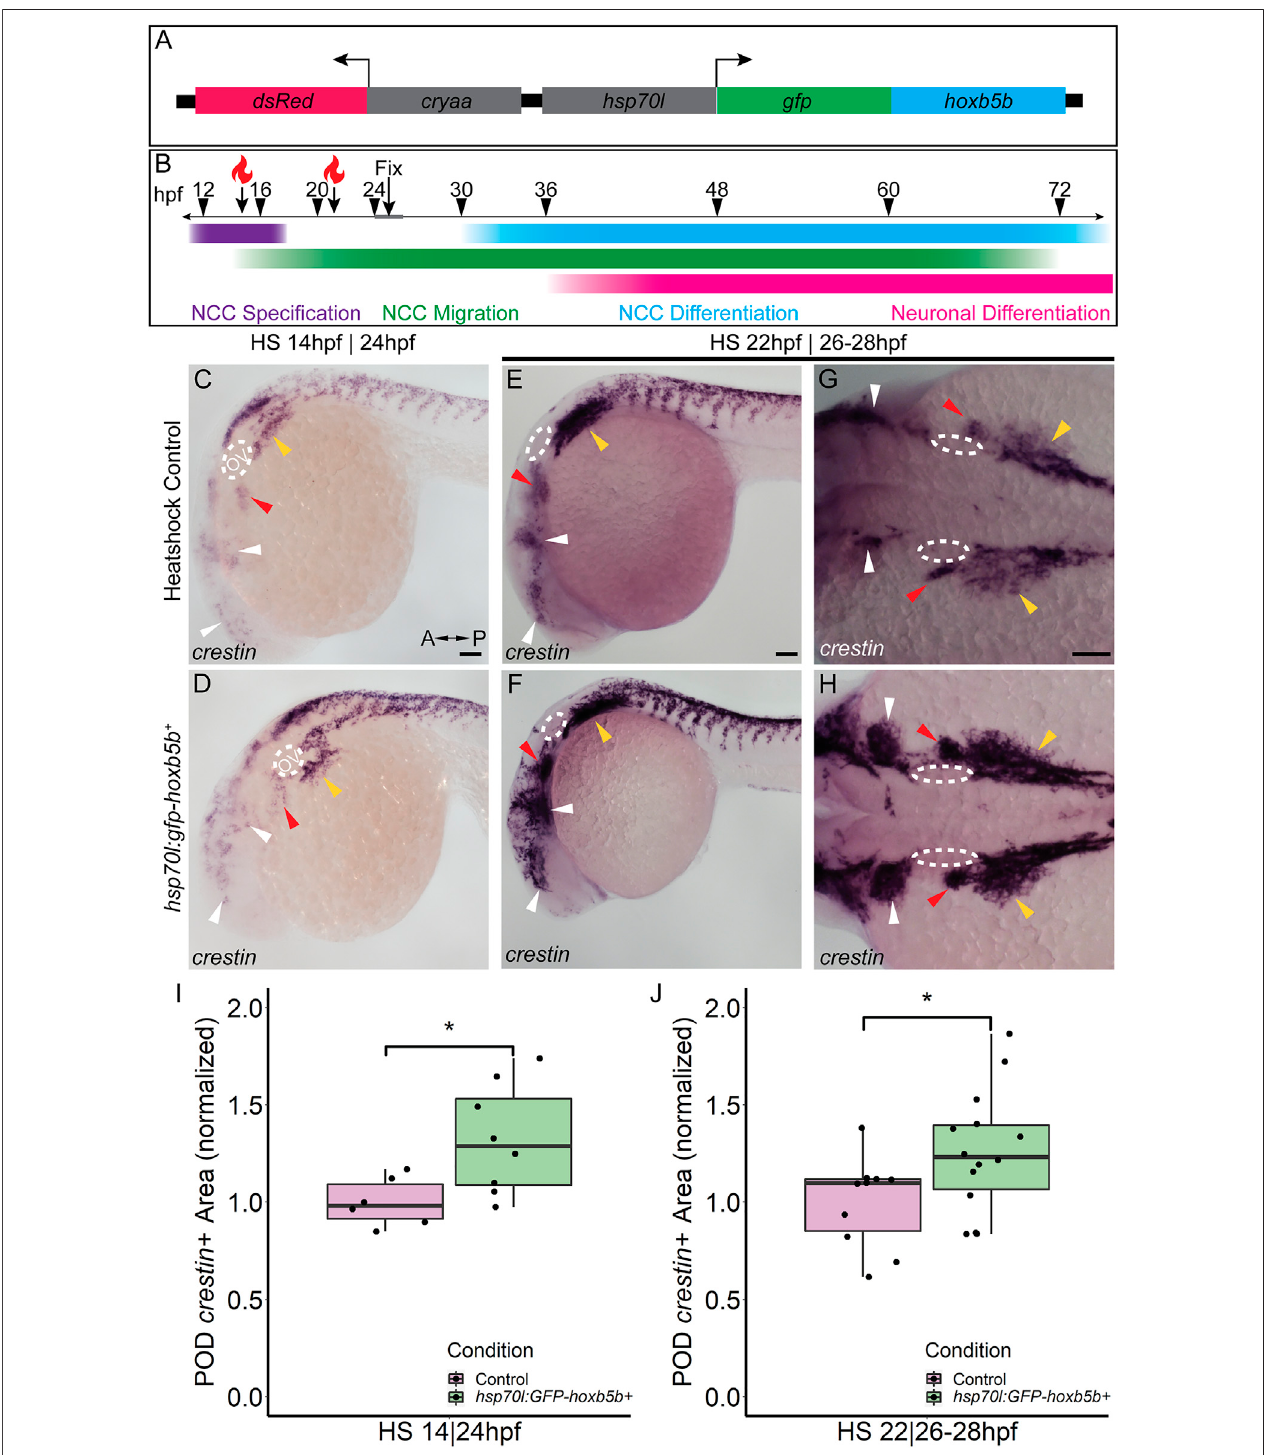
FIGURE 4 | Temporally controlled overexpression of Hoxb5b during the fi rst day in development is suf fi cient to expand the neural crest pool. (A) Schematized modelofthe hsp70l:gfp-hoxb5b;cryaa:dsRed geneticconstruct. (B) Illustrationdepictingspeci fi cperiodsofheatshockforembryogroupsrelativetoclassicalhallmarks of zebra fi sh NCC development. (C,D) in situ hybridization using a probe for crestin in hsp70l:GFP-hoxb5b + embryos heat shocked at 14 hpf and fi xed at 24 hpf, compared to GFP − sibling controls treated in parallel. Dramatic expansion of the POD can be seen (yellow arrowheads) in the Hoxb5b overexpressing embryos, whilemoresubtle expansionisnoted inthecranialNCC (whitearrowheads) and pre-otic crest(red arrowheads). (E – H) Similar to (C,D) in situ hybridization witha crestin